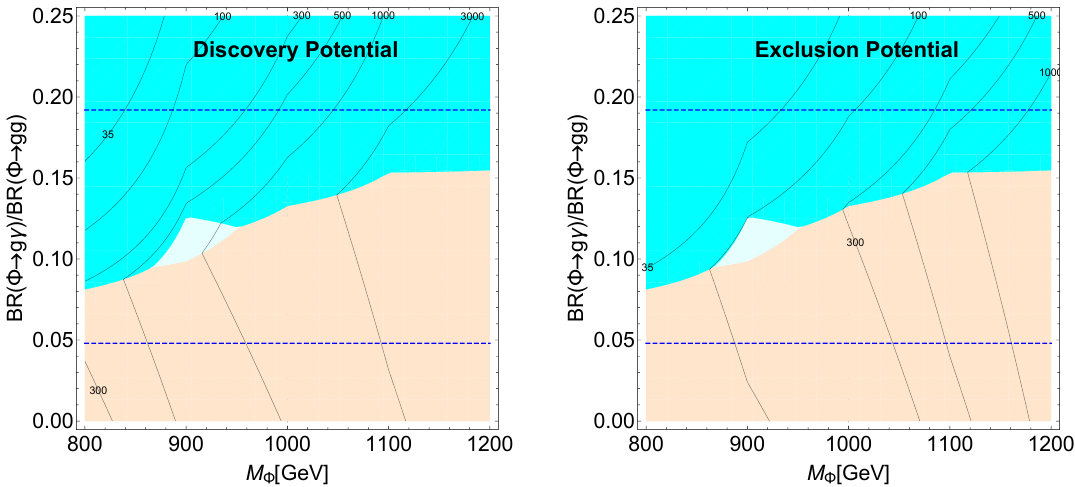
Figure 9 . Contours of the luminosity with expected Z = 5 (\Discovery Potential") on the left and Z = 2 (\Exclusion Potential") on the right, as a function of M (cid:8) and the relative branching fraction B ((cid:8) ! g(cid:13) ) = B ((cid:8) ! gg ), based on the HL-LHC analysis strategy in this subsection.